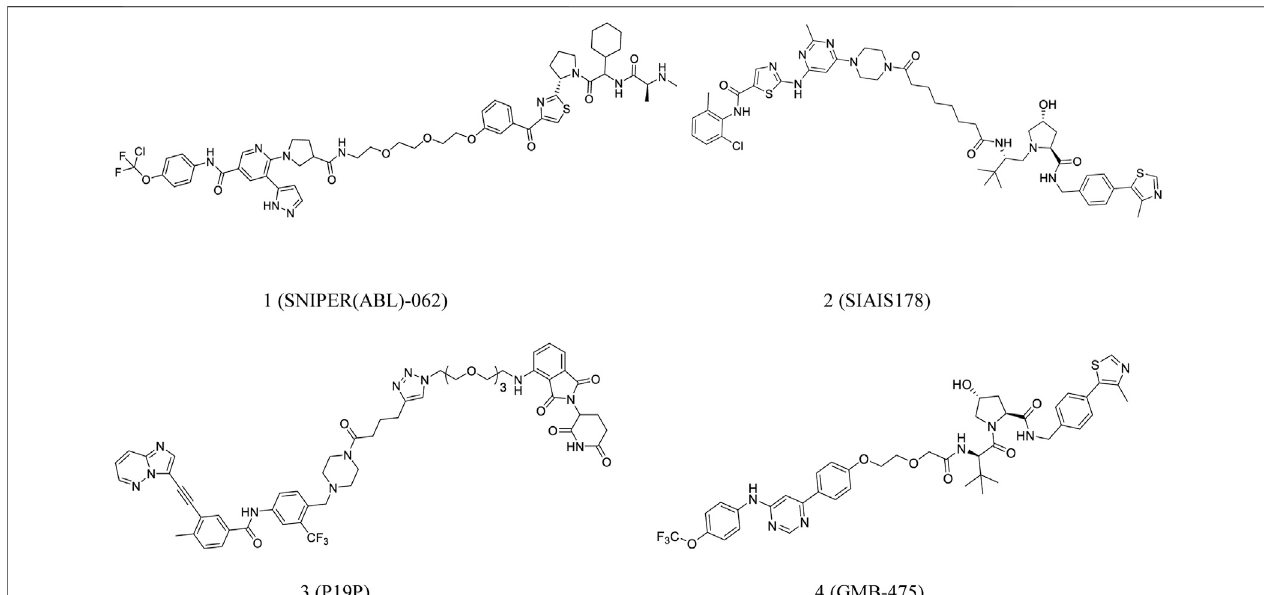
FIGURE 2 | Chemical structures of PROTACs targeting BCR-ABL.